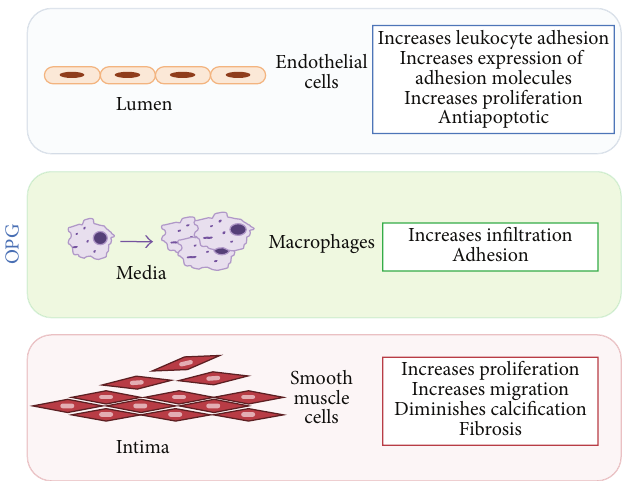
Figure 4: Pathological role of osteoprotegerin in endothelial cells, smooth muscle cells, and